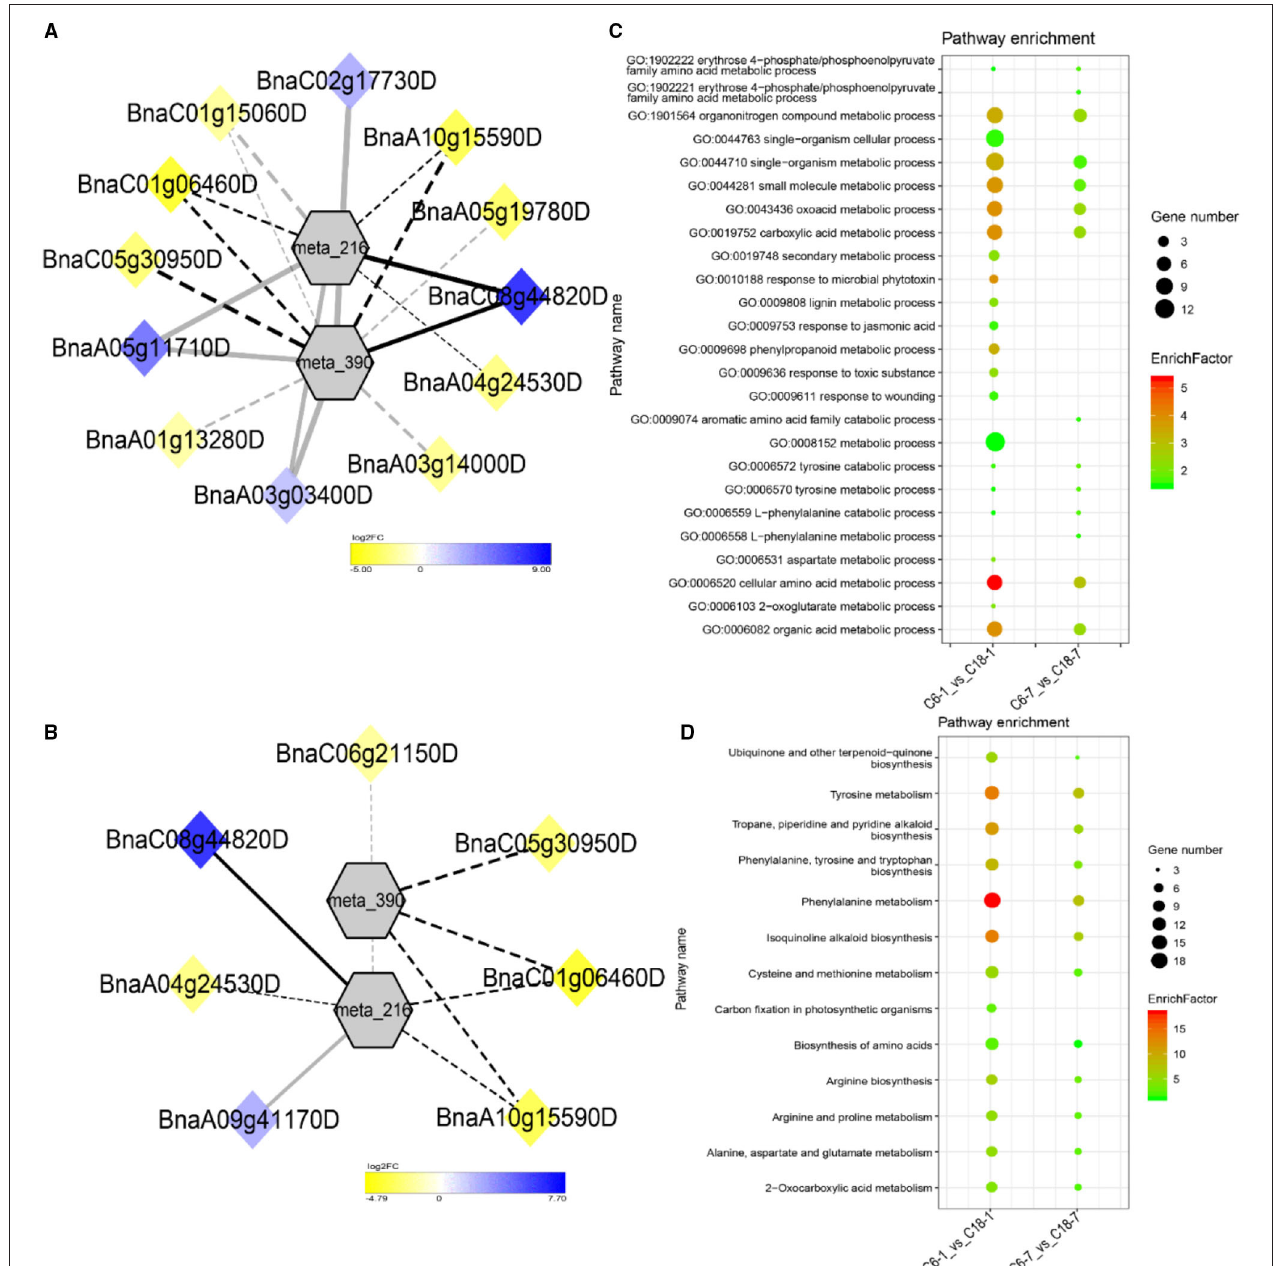
FIGURE 8 | Correlation network analysis between DAMs and regulatory genes related to CS. (A) Analysis of C6-1 vs. C18-1 and (B) analysis of C6-7 vs. C18-7. Log 2 FC of genes, in response to CS, are indicated in heatmap colors ranging from yellow (downregulated) to blue (upregulated); log 2 FC values are indicated in the legend; the width of the connecting lines indicating the strength of the correlation; solid lines indicating the positive correlation and dashed lines indicating the negative correlation; black lines indicating the common genes and gray lines indicating the specific genes accumulated at that time point. (C,D) Scatter plots for the GO-BP enrichment analysis and KEGG pathway enrichment analysis of DEGs from G4, respectively. Only the highly enriched and most relevant terms and pathways are shown in the plots ( Q < 0.05.) –log 10 ( Q ) for enrichment